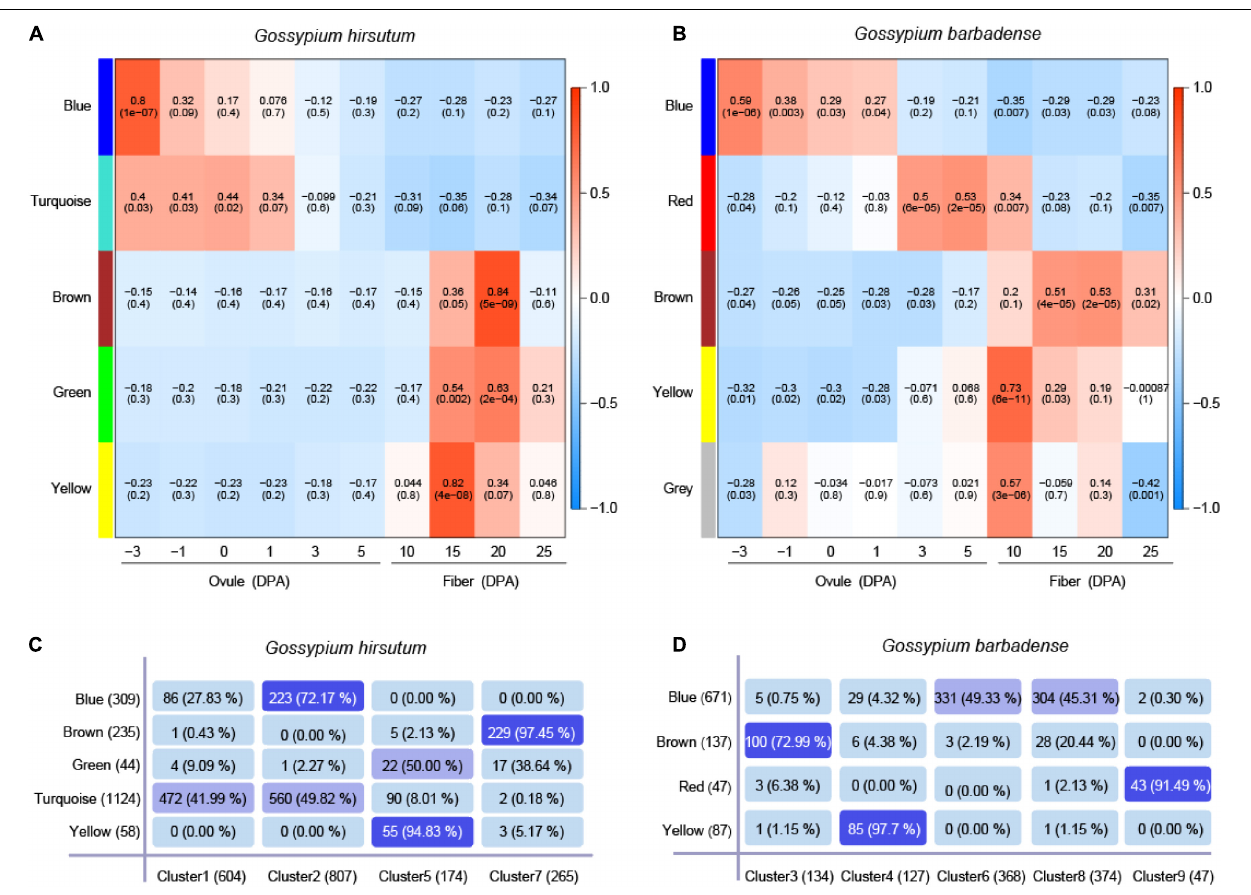
FIGURE 4 | Co-expression network construction and overlap analysis with MaSigPro. (A,B) Weighted gene co-expression network analysis (WGCNA) of the genes with dominant expression in G. hirsutum ( N = 1,850) and in G. barbadense ( N = 1,050) at ten time points of fiber development, respectively. Each row represents a module, and the correlation coefficient and the p -value calculated by Fisher’s exact test are shown in each square. The table is color-coded by correlation according to the color legend. The intensity and direction of correlations are indicated on the right of the heat map (red, positive; green, and negative). (C,D) Overlapping analysis of genes in the four clusters and five modules in G. hirsutum , while genes in the five clusters and four modules in G. barbadense